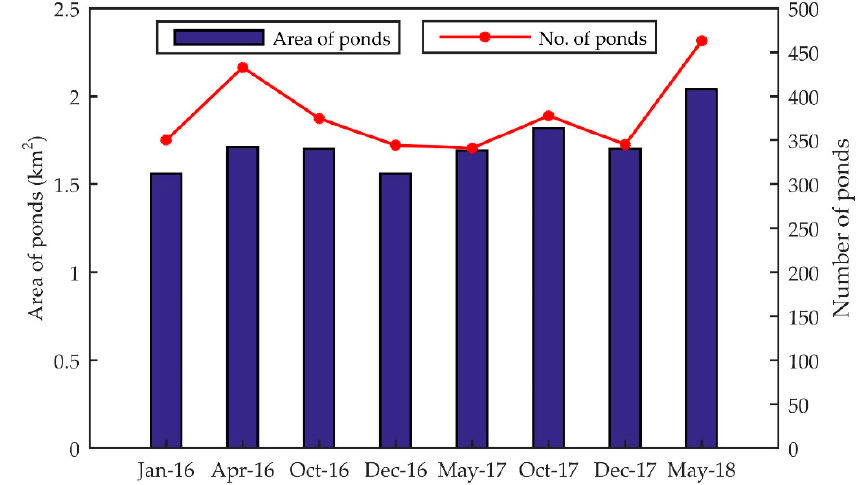
Figure 8. Seasonal changes in the number and area of the supraglacial ponds ( > 0.0005 km 2 ) between January 2016 and May 2018 obtained from Sentinel-2 images of 10-m resolution.